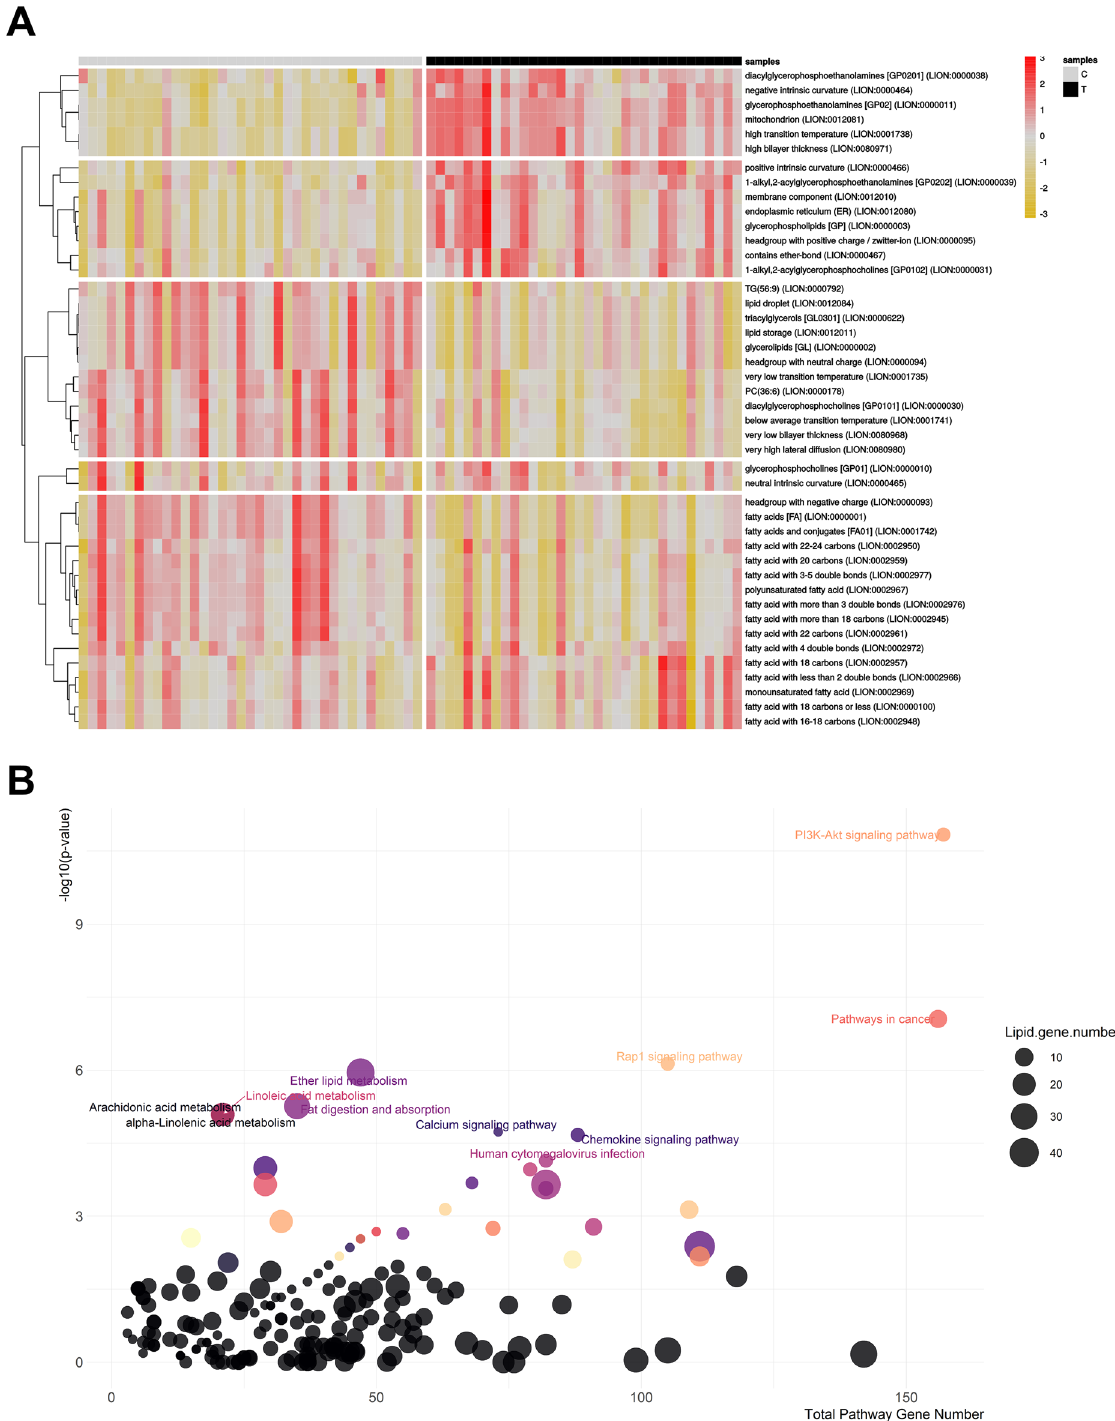
Figure 4. Lipid ontology enrichment and lipid-gene association network analysis. ( a ) Lipid ontology (LION) PCA-heatmap of Tuberculosis and Control group. ( b ) Bubble plot of lipid-gene association pathways. C control group, T Tuberculosis group, PC phosphatidylcholine, TG triacylglycerol, LION Lipid